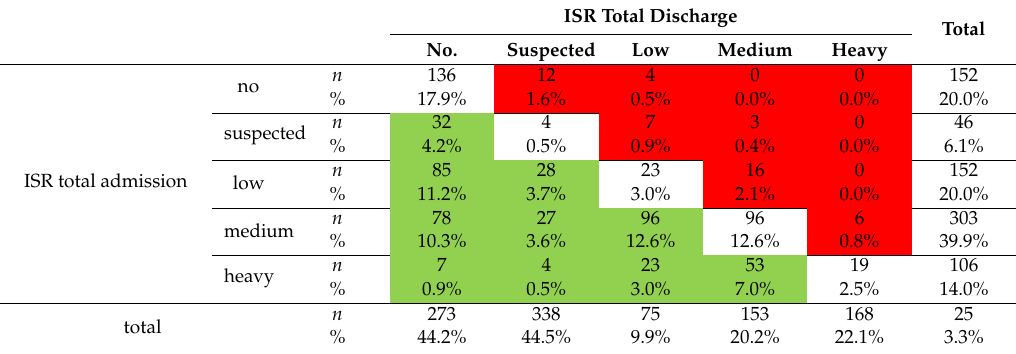
Table 3. Cross-classified table of the change in symptom classification between admission and discharge.